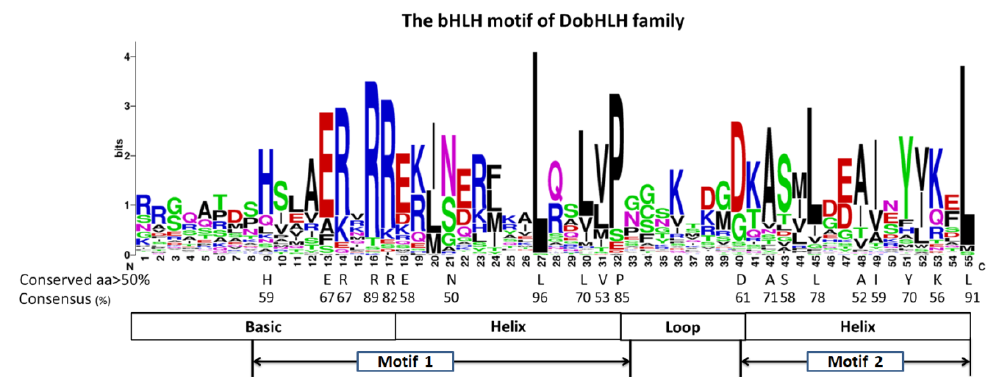
Figure 4. Analysis of the conserved amino acids in all DobHLH domains. The overall height of each amino acid represents the sequence conservation at that position. The conserved AAs and the consensus of more than 50% among 98 DobHLH domains are indicated in black letters. Table 2. The predicted types of DNA-binding based on DobHLH domain sequences. Predicted DNA-Binding Types Based on the bHLH